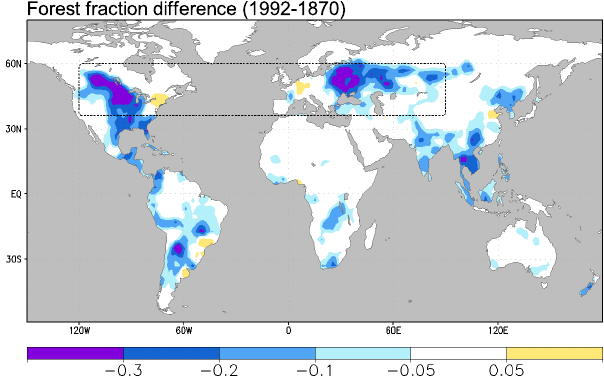
Fig. 5. Forest fraction difference between the preindustrial period and present-day (1992–1870) prescribed in LUCID land surface models (model mean). Dashed box indicates the land areas of large deforestation further used for specific